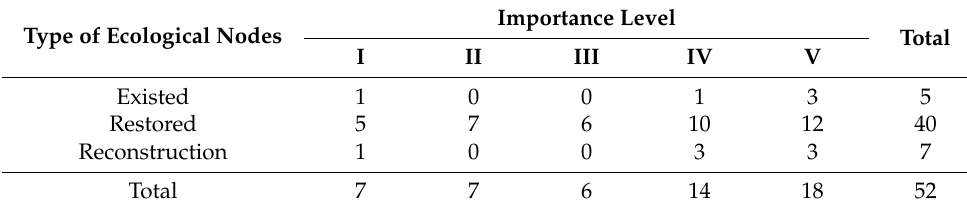
Figure 12. Importance and classification of ecological nodes in the Ningdong Energy and Chemical Industrial Base (NECIB): ( a ) different importance levels of ecological nodes by IIC; and ( b ) different types of ecological nodes by VFC. Table 11. Statistics of the ecological nodes.